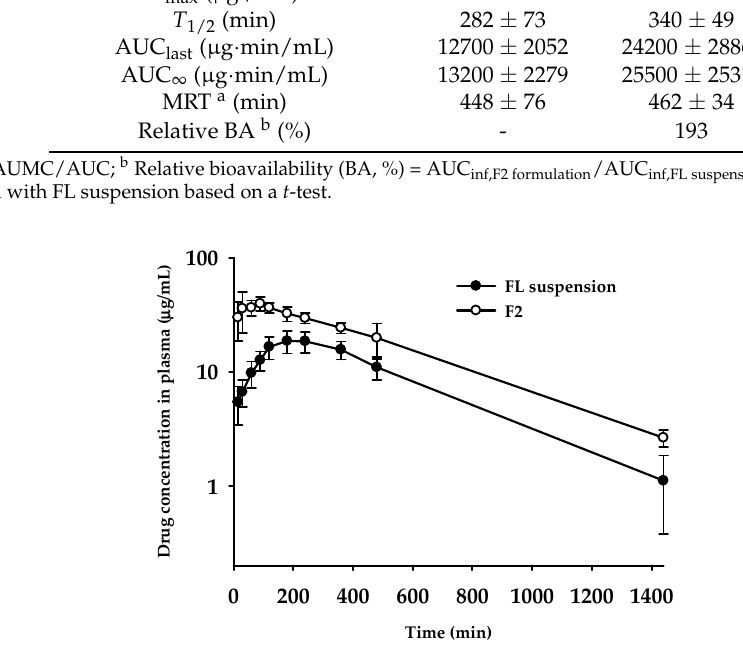
Figure 5. Plasma concentration–time profiles of FL after oral administration of FL suspension in 0.3% CMC-Na and F2 formulation at the dose of 10 mg/kg in rats. Each point represents the mean ± standard error ( n = 4–5). Table 4. Pharmacokinetic parameters of FL after oral administration of FL suspension in 0.3% CMC-Na and F2 formulation, at a dose of 10 mg/kg in rats ( n = 4–5).